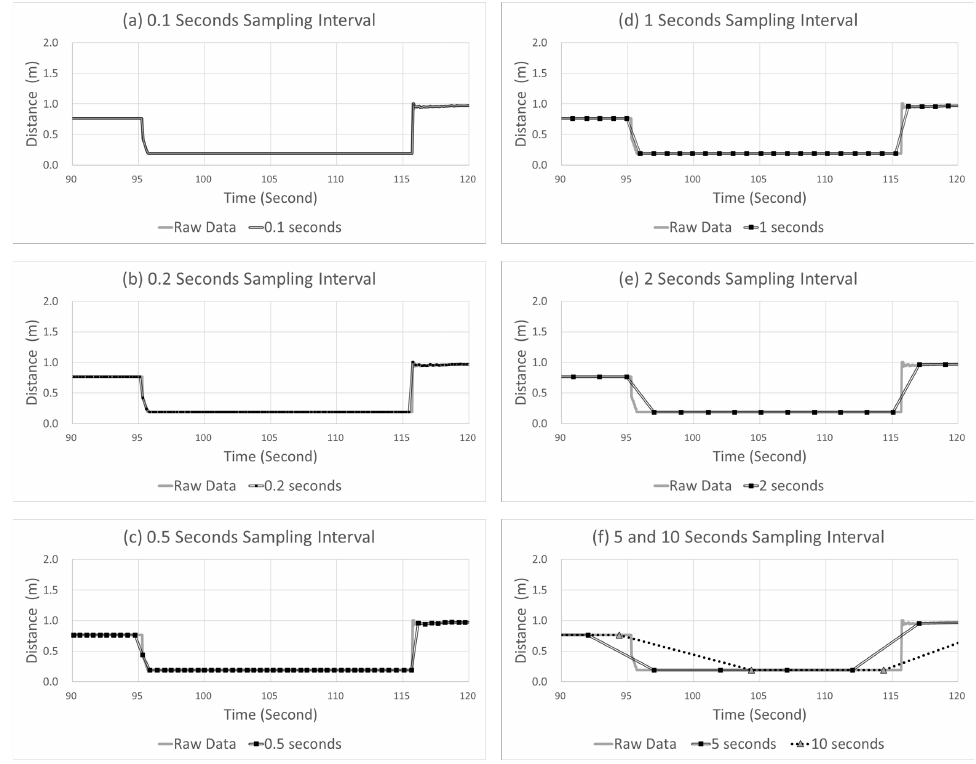
Figure 11. Example case of LPV varying sampling intervals.